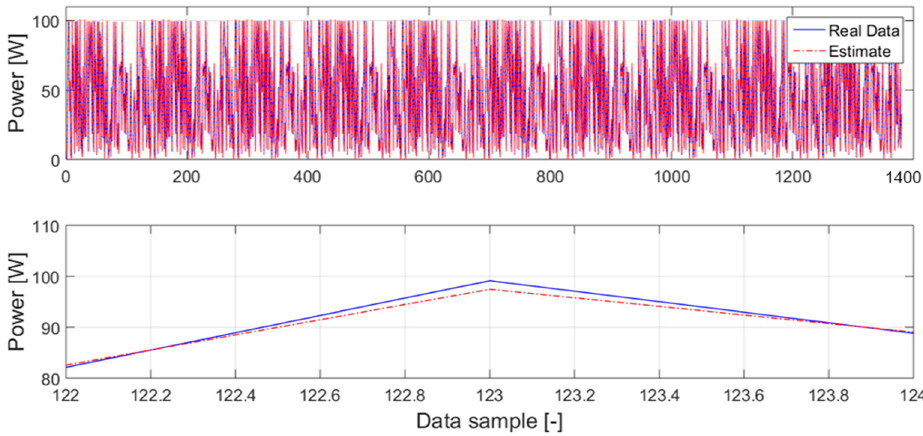
Figure 14. Comparison between simulated data and the values obtained by the ANN.